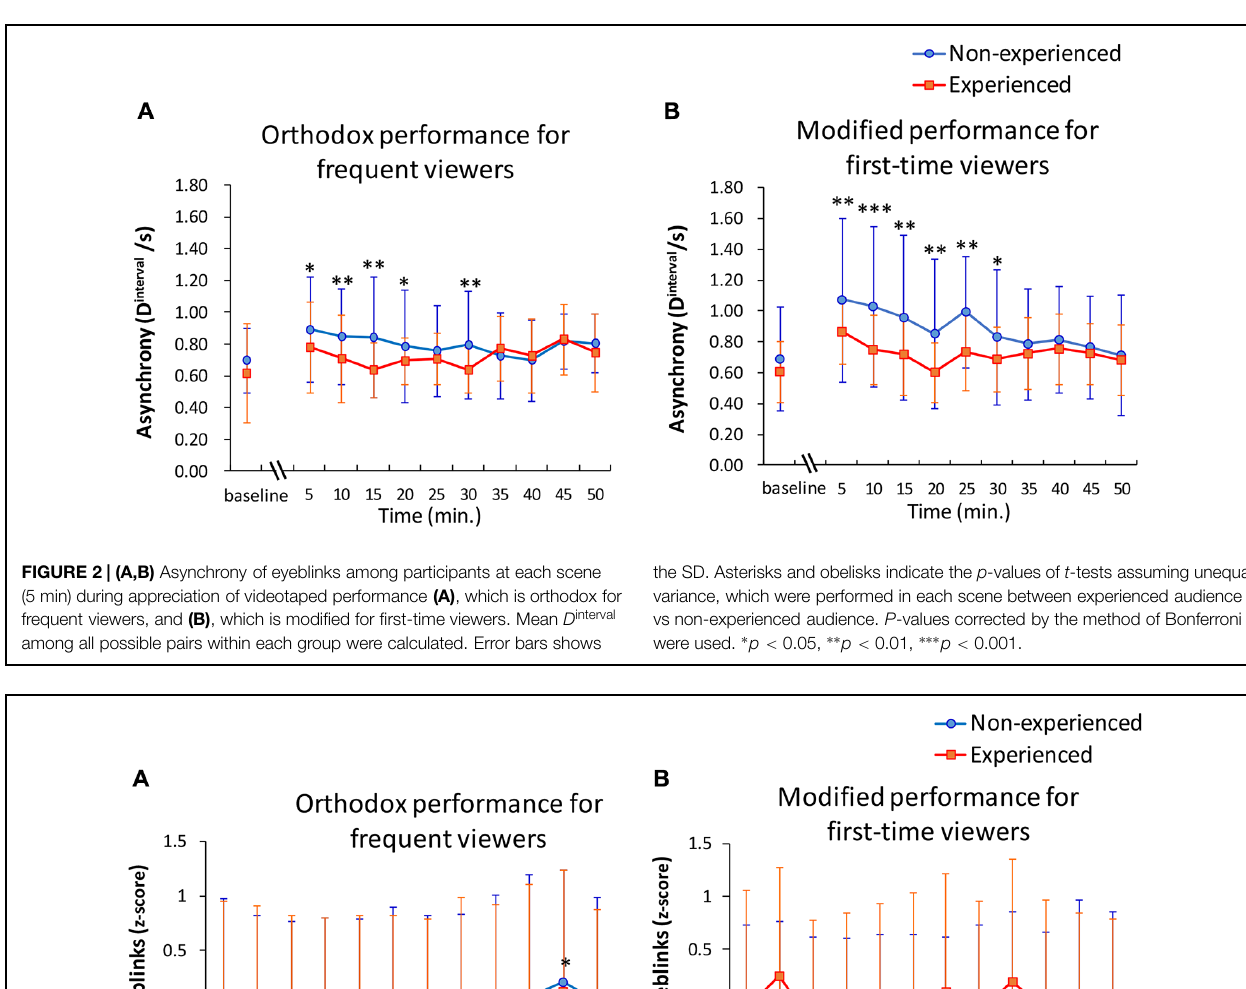
FIGURE 3 | (A,B) z -scores of eyeblinks before and after onsets of laughter recorded in performance (A) Orthodox and (B) Modified. Error bars show the SD. An asterisk indicates a p -value of one sample t -test for the mean against the null hypothesis. P -values corrected by the method of Bonferroni were used. ∗ p < 0.05.